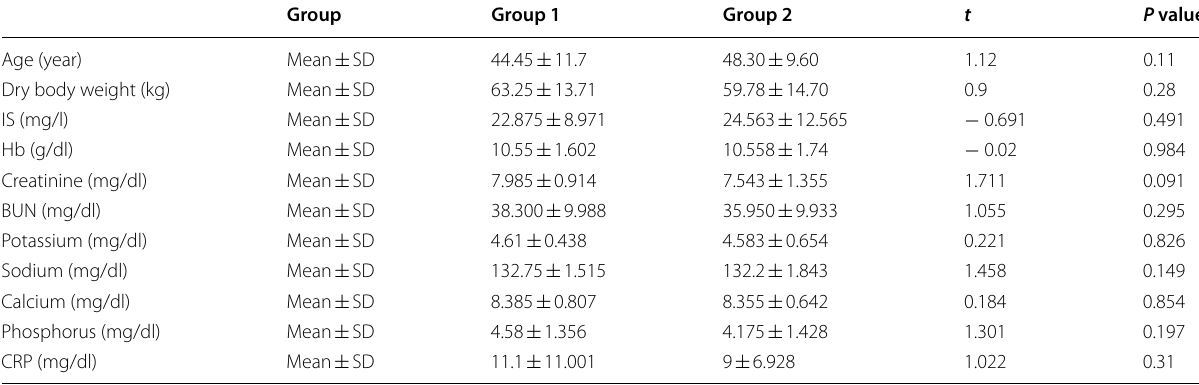
Table 1 Comparison between symbiotic and placebo group as regards mean age, dry body weight, IS, and other laboratory data at baseline